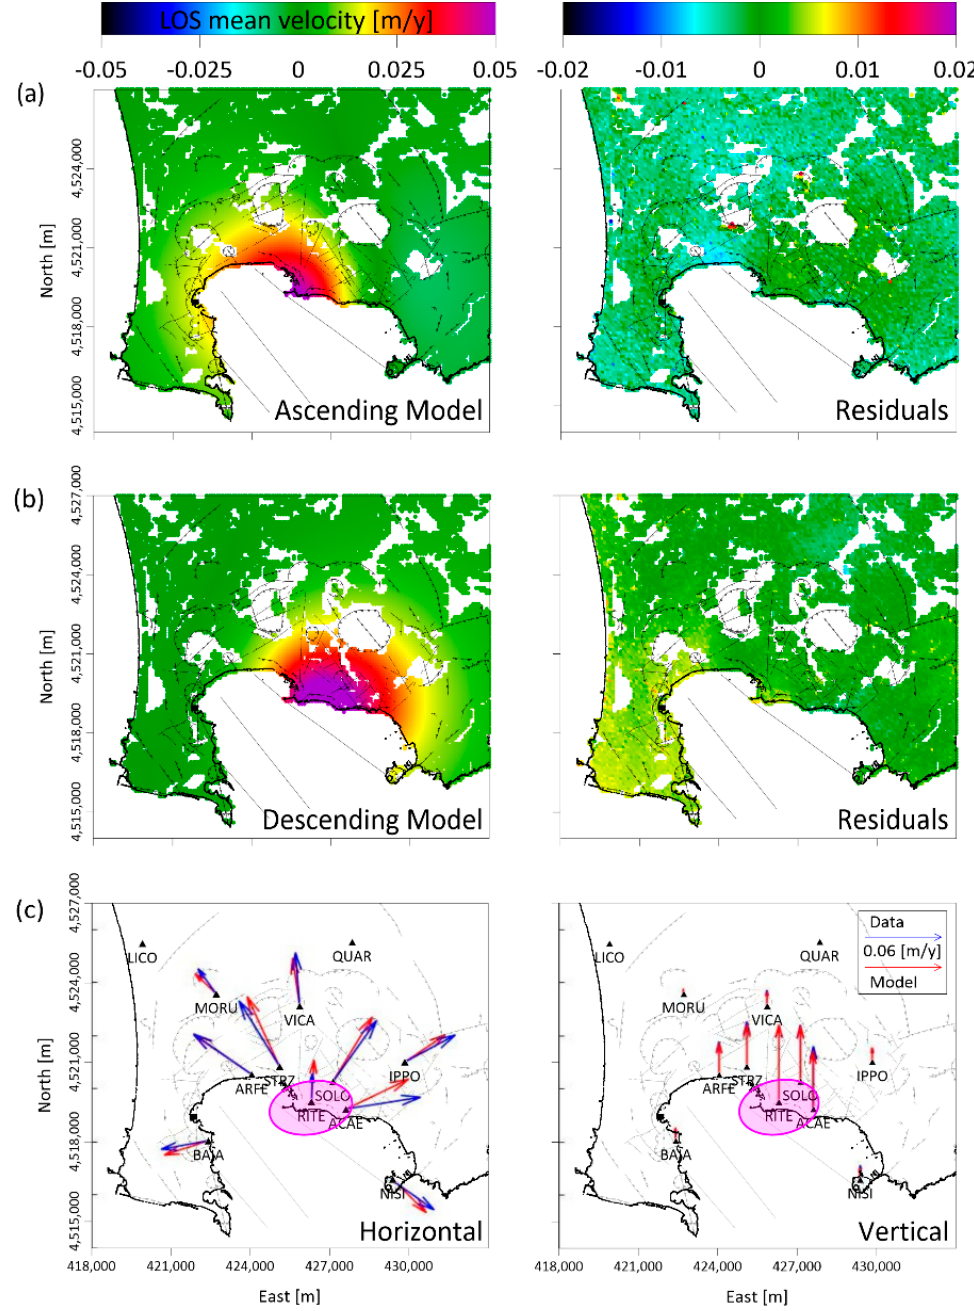
Figure 4. Stationary FE model results. Comparison between observed (see Figure 2a) and modeled ( a ) ascending and ( b ) descending LOS mean velocity of 2011–2013 DInSAR measurements; LOS mean velocity model (left panel) and velocity residuals (right panel). ( c ) Horizontal (left panel) and vertical (right panel) components of the observed (blue) and modeled (red) GPS mean velocities. The magenta ellipse is the retrieved source projection on the map.